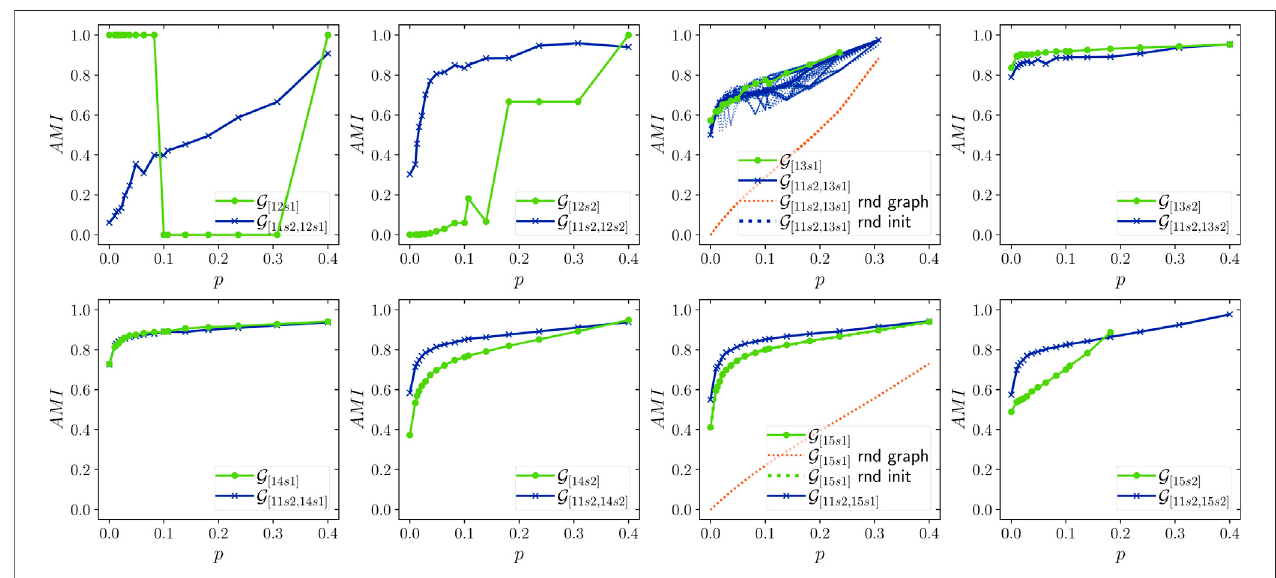
FIGURE 9 | AMI as a function of p .